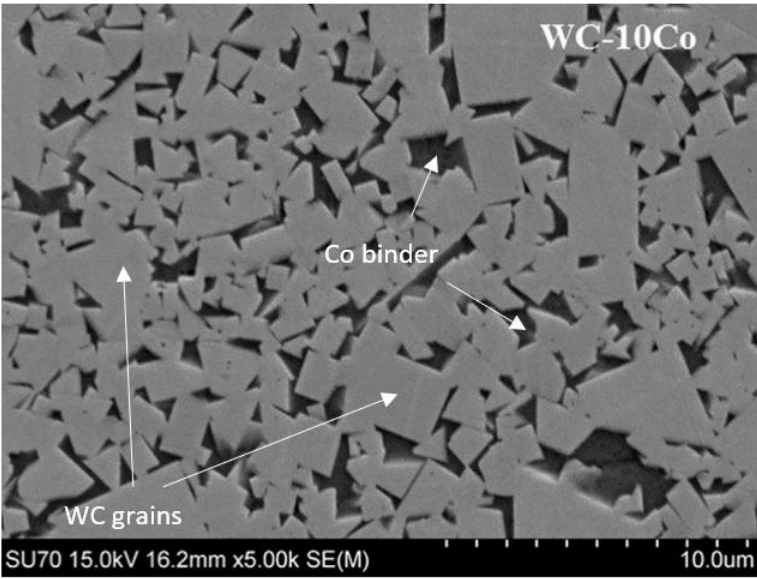
Figure 2. SEM micrograph of the WC-10Co composite.